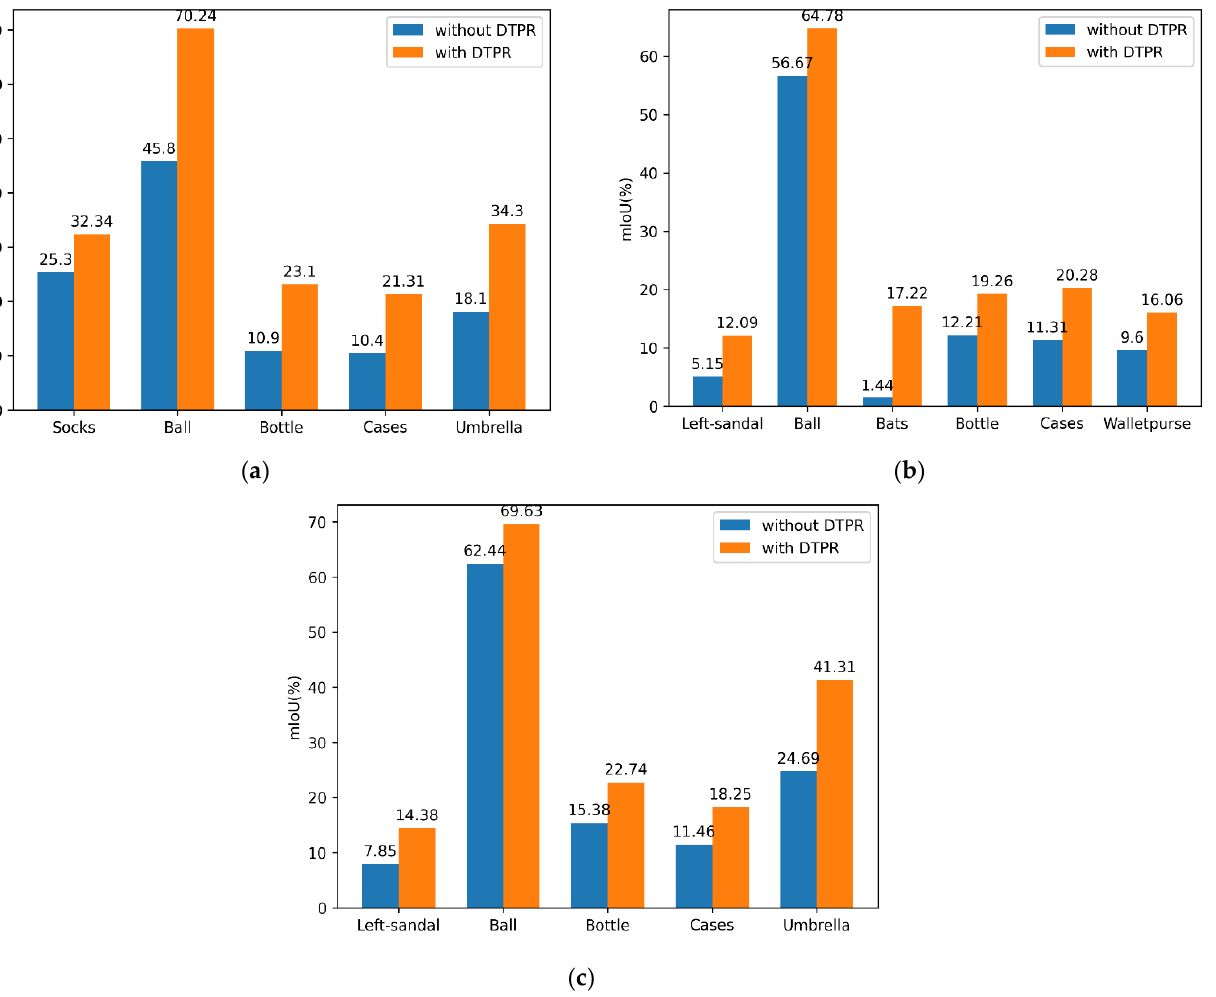
Figure 6. The mIoU performance with different models on some categories. ( a ) PSPNet is used as the